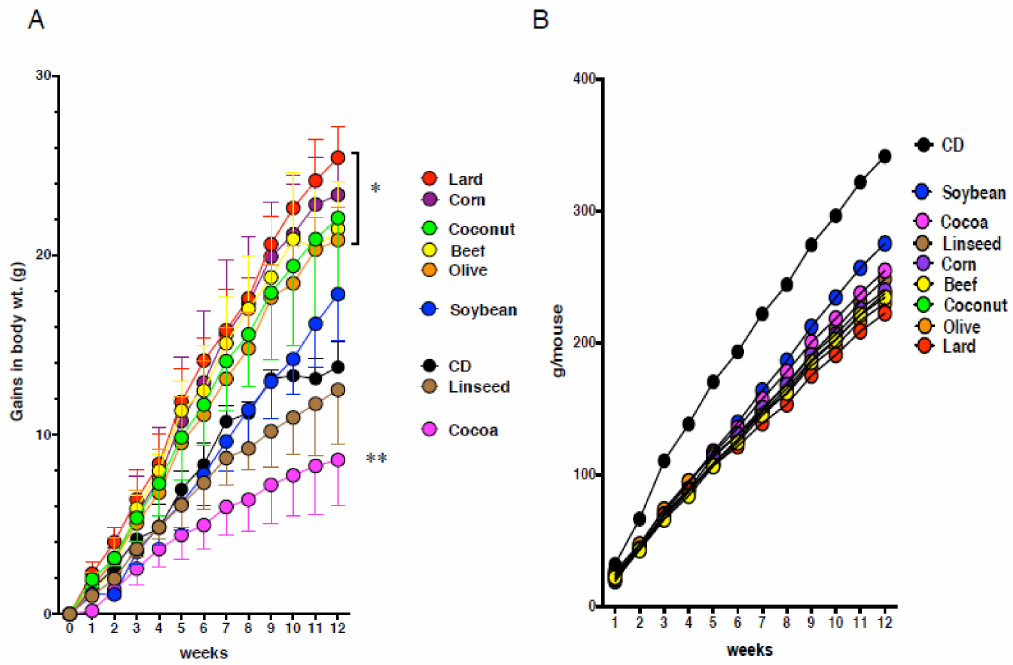
Figure 1. Alteration of body weight and food intake of C57BL / 6J mice fed eight kinds of high-fat diets (HFDs). ( A ) Gains in body weight and ( B ) food intake of mice fed control (CD), beef tallow (Beef),